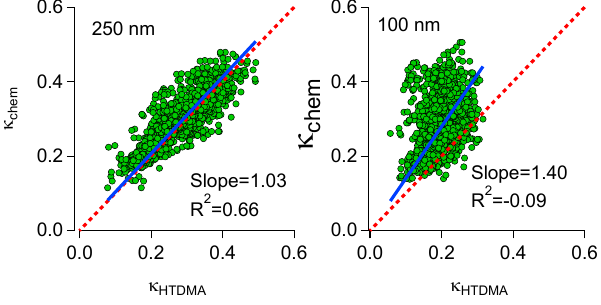
Fig. 4. Correlation between κ chem and κ HTDMA for particles with Fig. 4: Correlation between  chem and  HTDMA for particles with dry Dp=100 nm and 250 nm, 775 dry D p = 100 and 250nm, using PM 1 bulk chemical composition. using PM 1 bulk chemical composition. 776 Table 2. Fit parameters of the HGF as a function of the water activ- ity (Fig. 2).